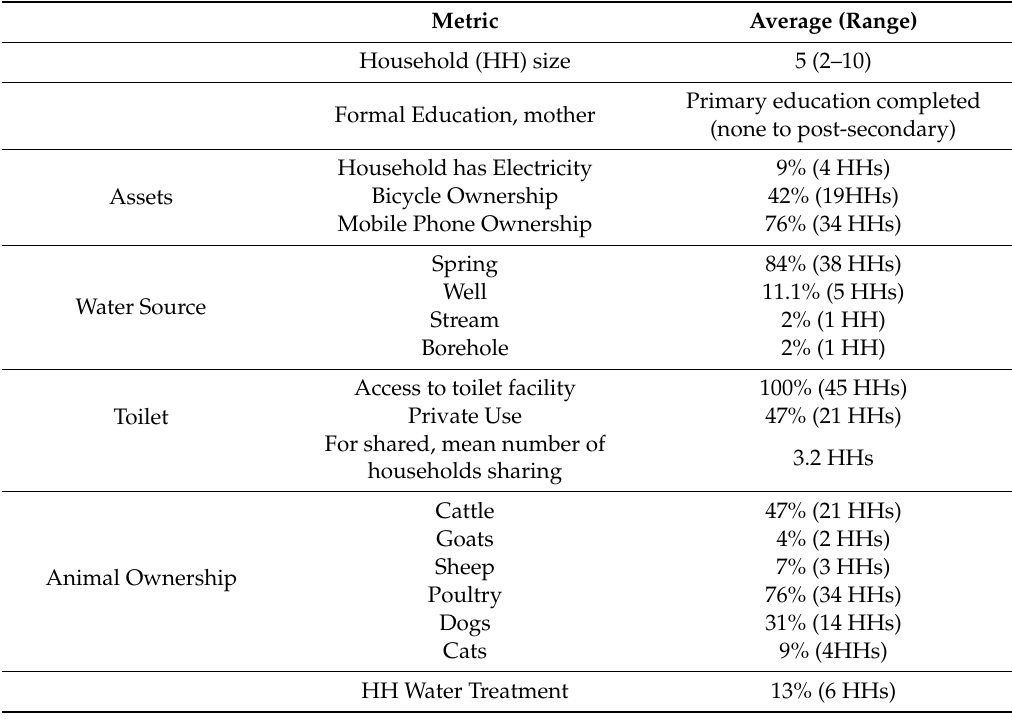
Table 3. Household characteristics ( n =